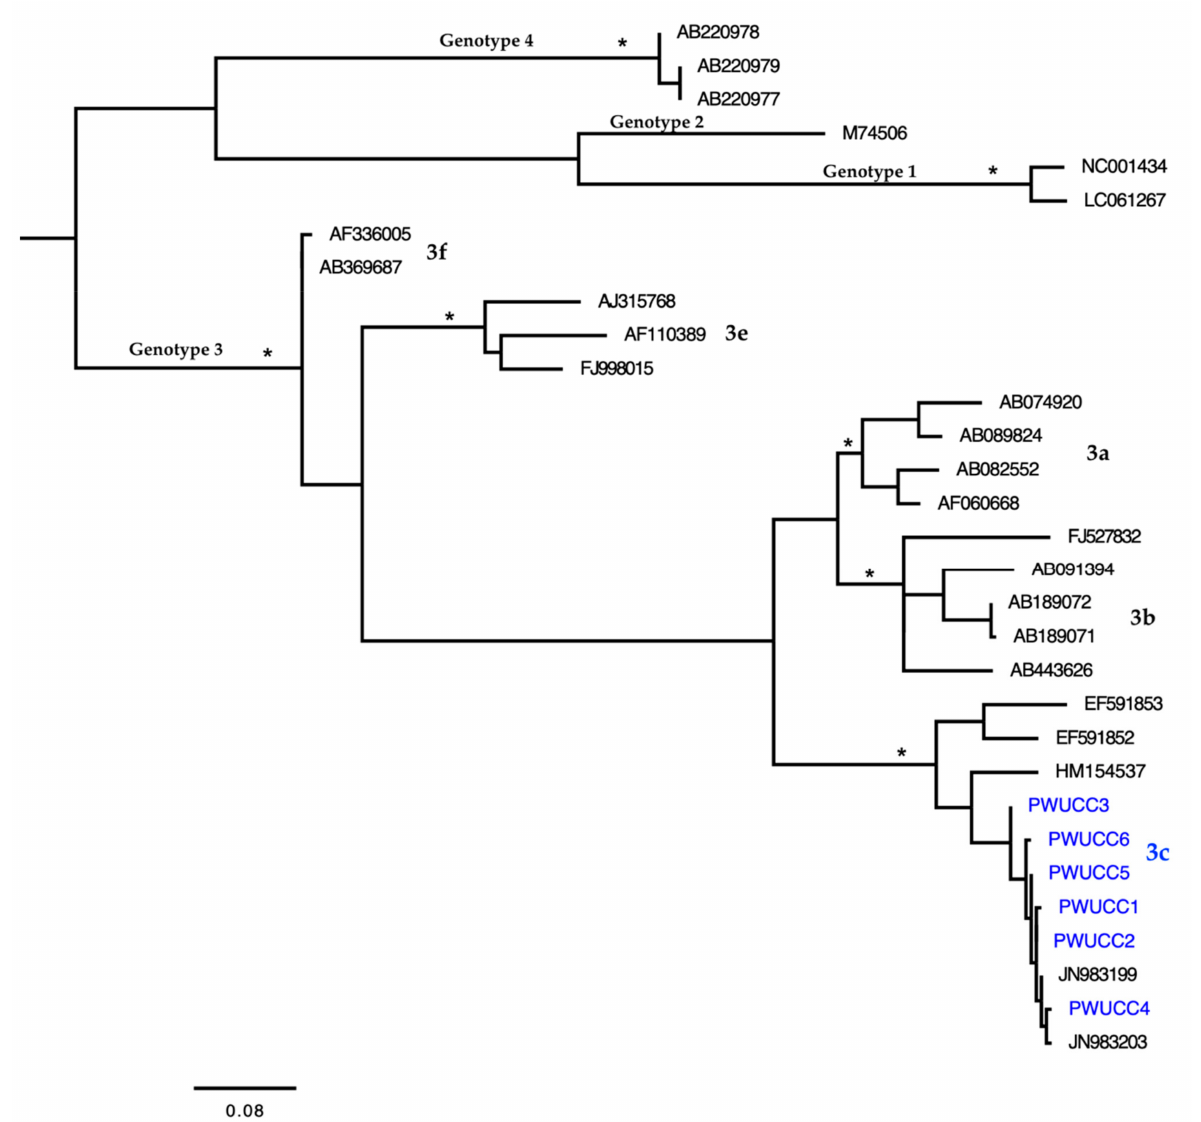
Figure 3. Maximum likelihood phylogenetic tree of hepatitis E virus (HEV) nucleotide sequences (from the 5 (cid:48) terminal region of ORF1 (255 nt)) isolated in six people who use crack-cocaine (PWUCC) in a remote region of northern Brazil with other sequences of this hepatotropic virus deposited on GenBank. The tree was rooted at the midpoint. The asterisks point to key nodes with high support (SH-aLRT scores ≥ 0.95). The samples of this study can be identified by the acronym PWUCC + number and are highlighted in